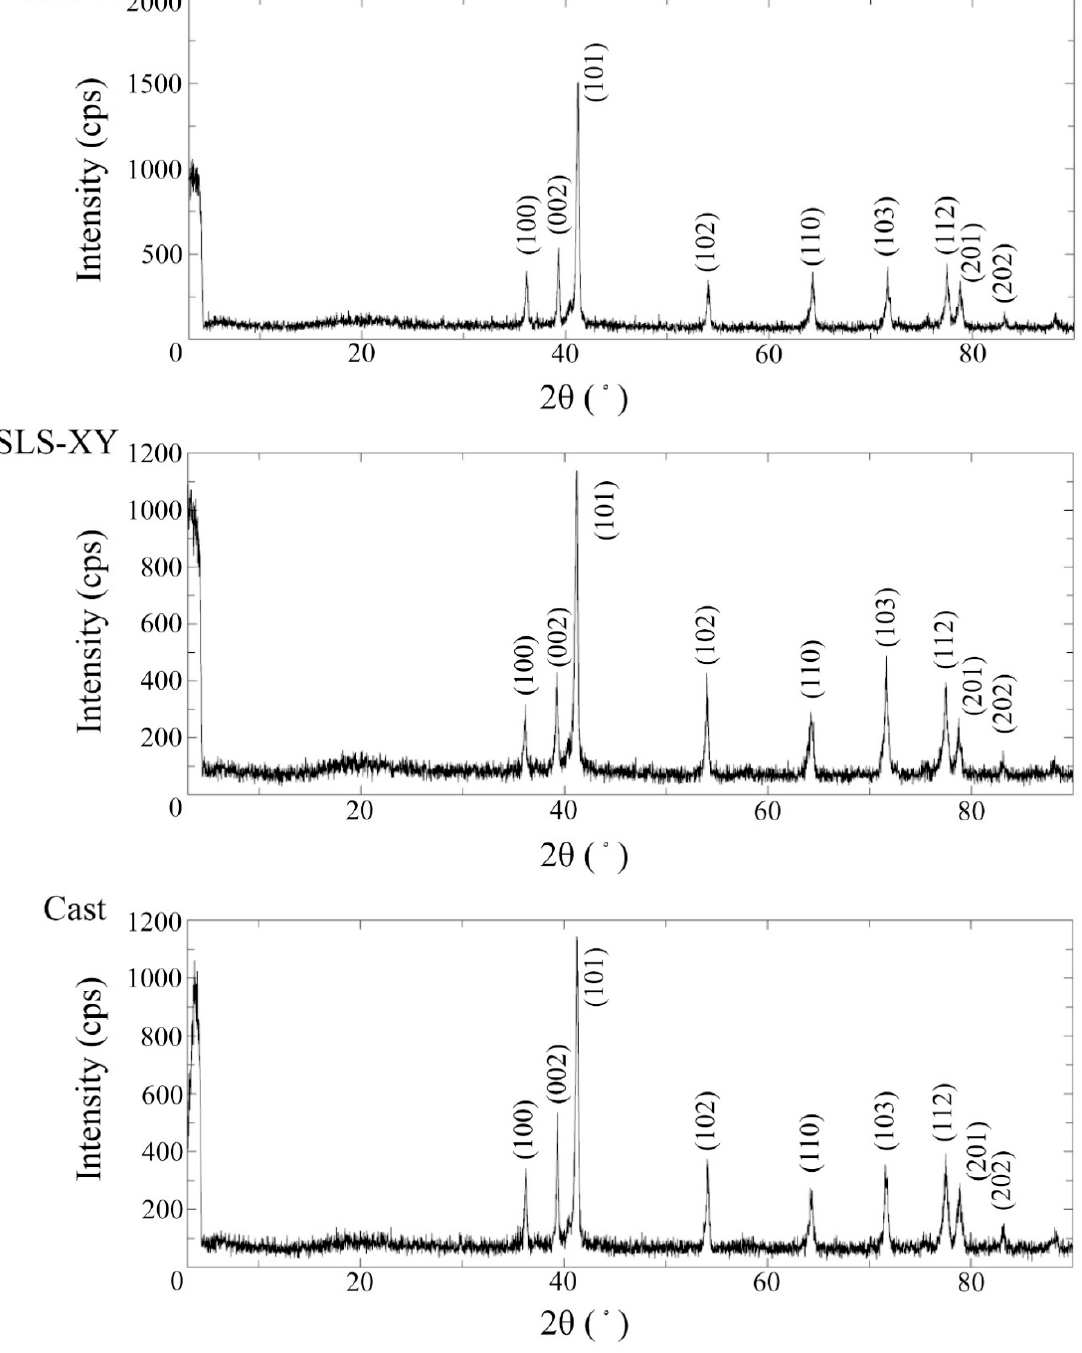
Figure 7. X-ray diffraction spectra of the SLS-Z, SLS-XY, and cast Ti-6Al-4V specimens. Figure 7. X-ray di ff raction spectra of the SLS-Z, SLS-XY, and cast Ti-6Al-4V